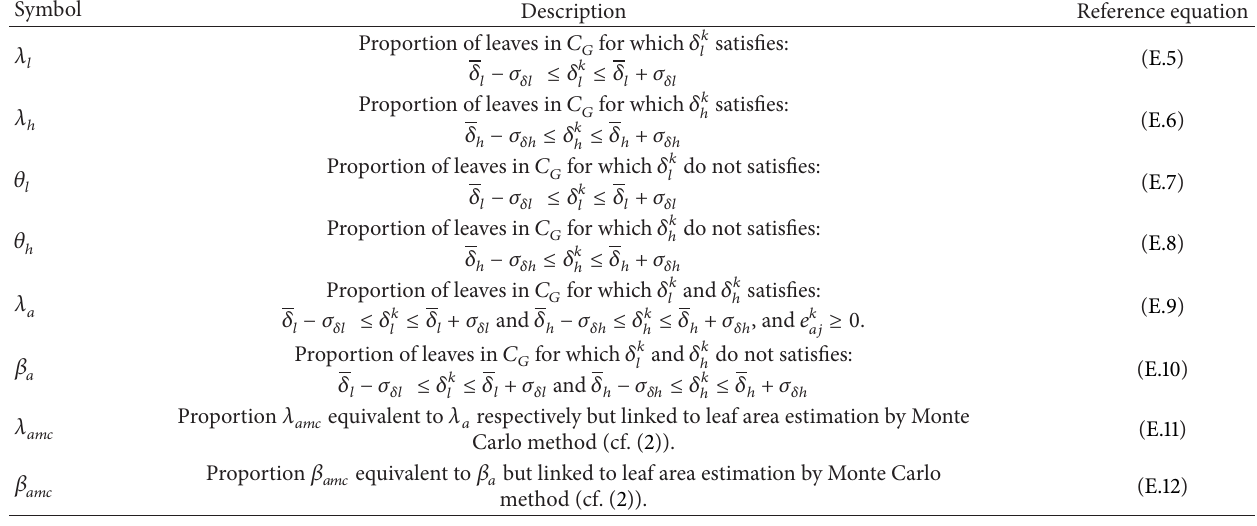
Table 5: Auxiliary statistics 𝜆 𝑙 , 𝜆 ℎ , 𝜃 𝑙 , 𝜃 ℎ , 𝜆 𝑎 , 𝛽 𝑎 , 𝜆 𝑎𝑚𝑐 and 𝛽 𝑎𝑚𝑐 used to obtain the set of leaves with estimation errors in range for a reliable estimation.